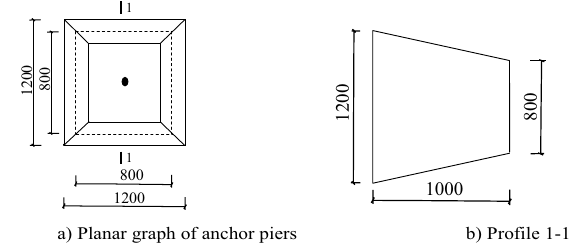
Figure 12. The parameters of anchor piers.